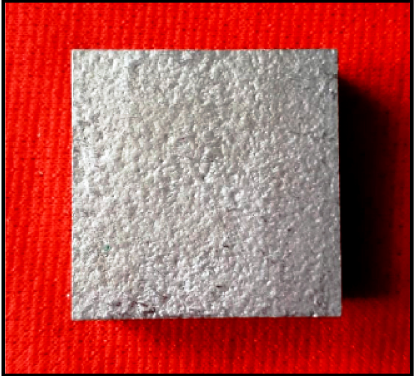
Figure 2. Stir casted AA8079 + TiN + ZrO 2 samples.